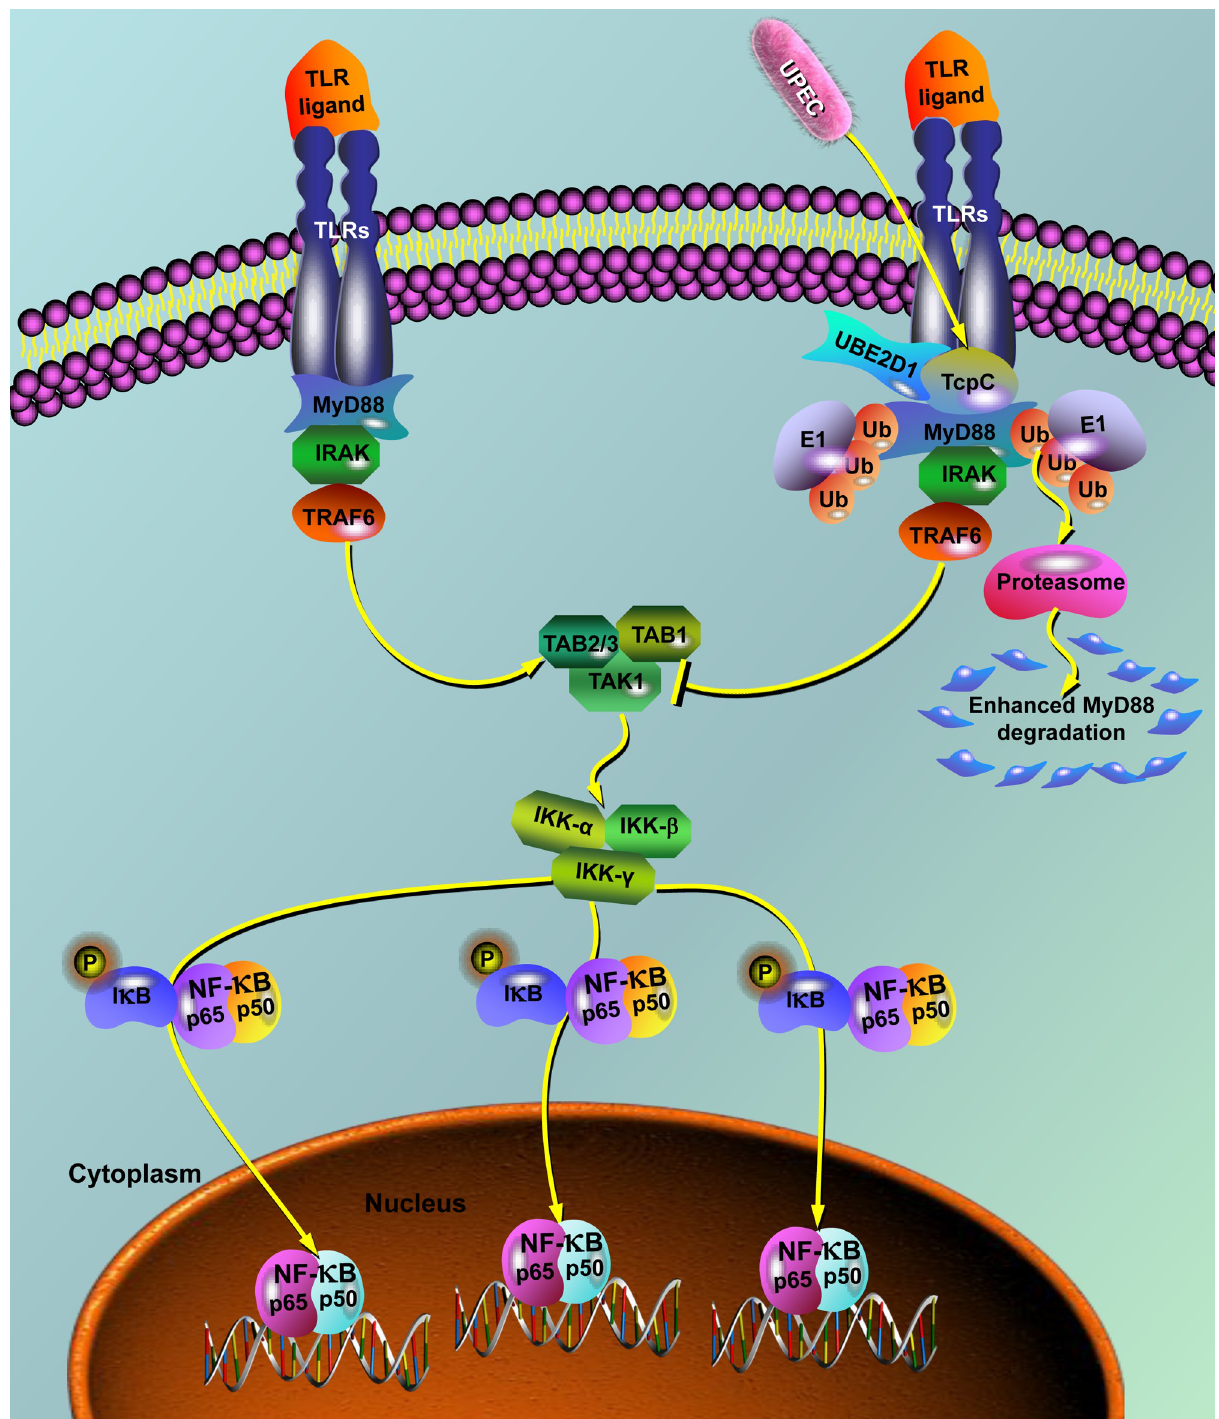
Fig 8. Schematic diagram of the molecular mechanisms by which TcpC blocks TLR signaling pathway. On stimulation by TLR ligand, all TLRs except for TLR3 recruit MyD88 via interactions between TIR domains on each other. MyD88 then recruit the down-stream signal molecules, leading to the activation of NF- κ B. Under the circumstance of UPEC infection, TcpC blocks TLR signaling pathway though two mechanisms: 1) TcpC-TIR blocks the interaction between TLR and MyD88 by direct association with MyD88; 2) TcpC functions as an E3 ubiquitin ligase, in combination with UBE2D1, to promote ubiquitination of MyD88, leading to degradation of MyD88 by proteasomes.